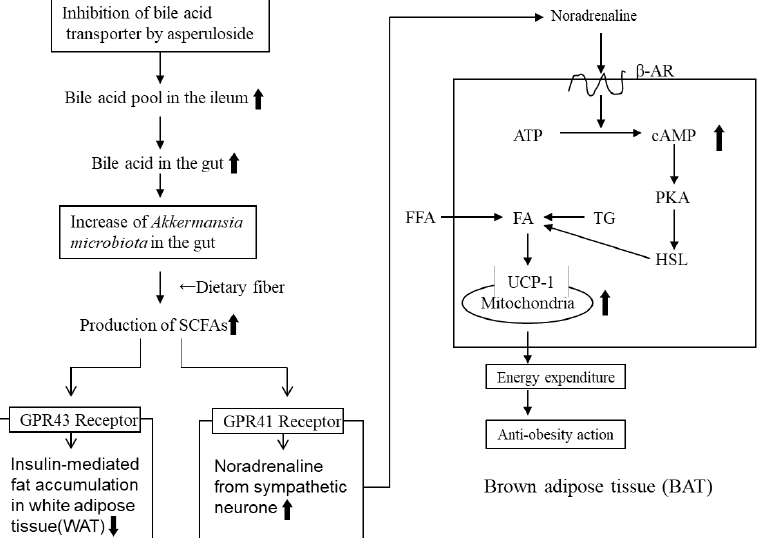
Figure 5. Mechanism of the anti-obesity effects of ELE-containing ASP via SCFAs. SCFAs: short-chain fatty acids, GPR: G protein-coupled receptors, β -AR: β -adrenergic receptor, PKA: protein kinase A, HSL: hormone sensitive lipase, TG: triglyceride, FA: fatty acid, FFA: free fatty acid. WAT: white adipose tissue. Small arrows next to words indicate the increases or decreases in the action or secretion.